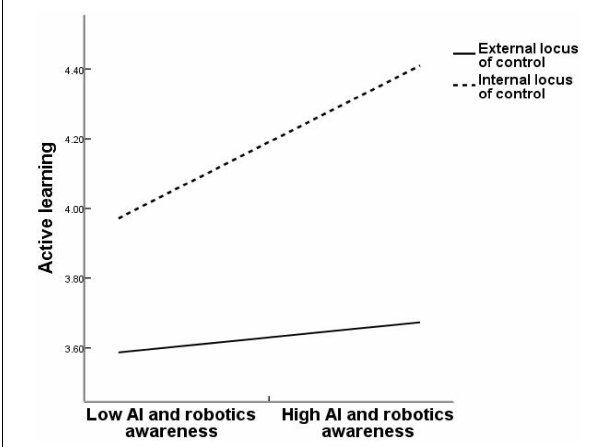
FIGURE 2 | Interaction effect of locus of control and artificial intelligence and robotics awareness (AIRA) on active learning.